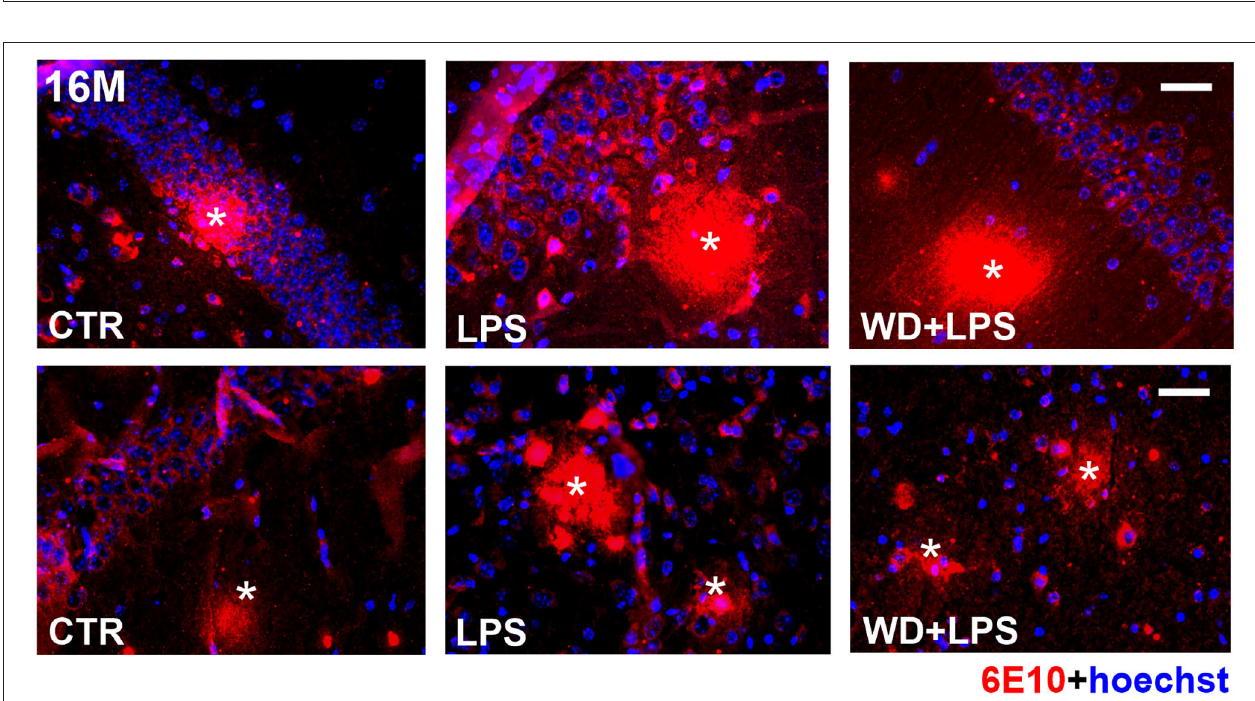
FIGURE 6 | hippocampus of 8-month-old APPswe mice fed with WD (WD and WD + LPS groups compared to CTR and LPS control groups). In control APPswe mice fed with standard diet (CTR) or treated with LPS, A β plaques were not observed even at the age of 12 months, and as shown in Figure 3 were detected as late as in 16-month-old mice group; the scale bar corresponds to 50 µ m; lens magnification × 20; red fluorescence—6E10 (amyloid- β staining), blue fluorescence—Hoechst (nuclei). (B) Graphs show increased levels of APP full-length and its C-terminal end fragments in WD and WD + LPS experimental groups in 4-month-old APPswe mouse hippocampus obtained in Western blot analysis. All the data are presented as arithmetic mean of APP full-length/actin and CTFs/actin ± SD ( n = from 4 to 8 animals per experimental group). The statistics were calculated using one-way analysis of variance (ANOVA) followed by Bonferroni’s post-test. A p -value of < 0.05 was considered a predetermined threshold for statistical significance.